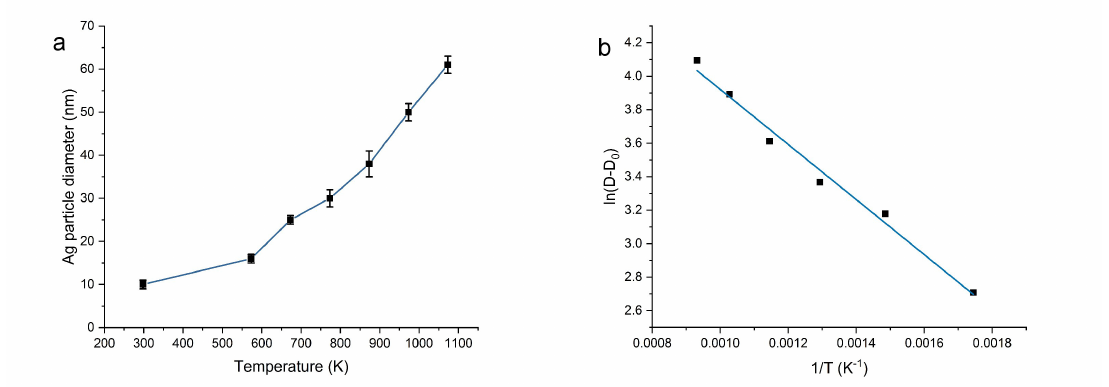
Figure 6. Graphical representation of the mean diameter growth of Ag particles in different temperatures ( a ). The error bars represent the standard error. An Arhennius type plot based on Equation (6) for determination of activation energy ( Q A ) for Ag NP growth on the SiO 2 matrix ( b ). During Ostwald ripening, particles grow larger in size due to the dissolution of smaller